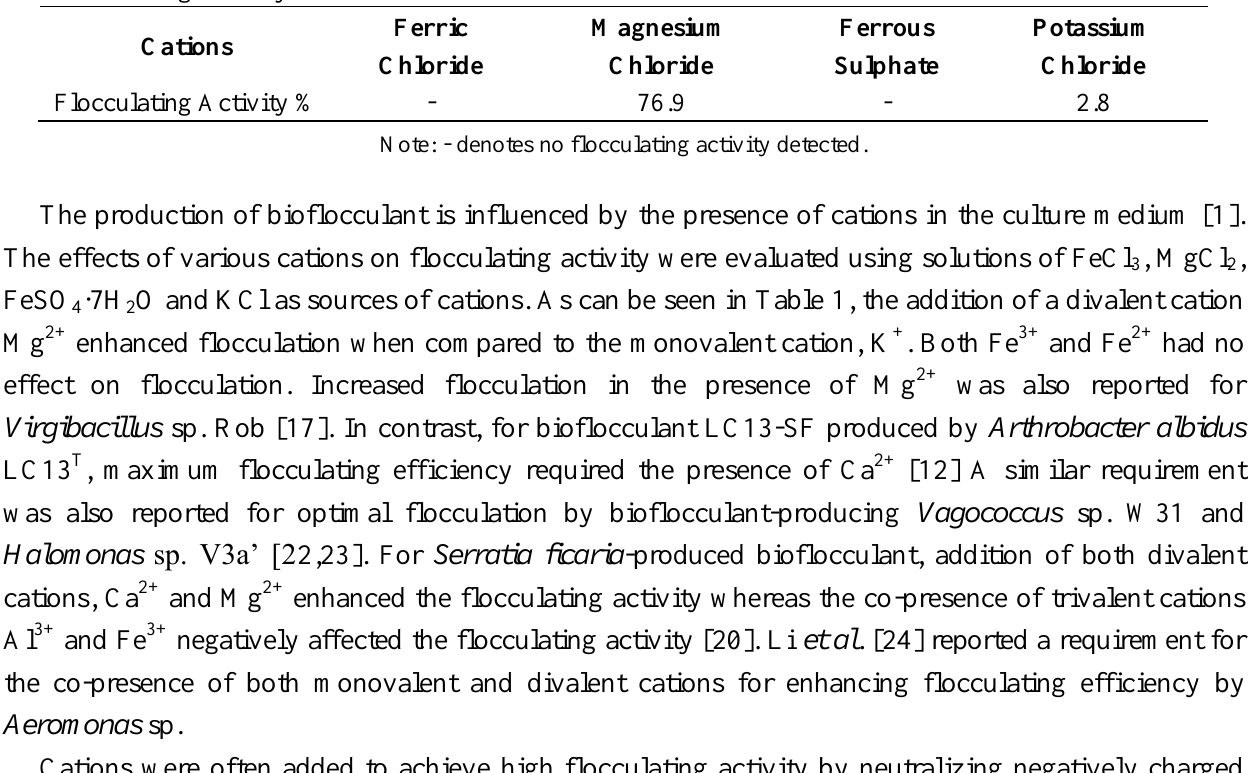
Note: - denotes no flocculating activity